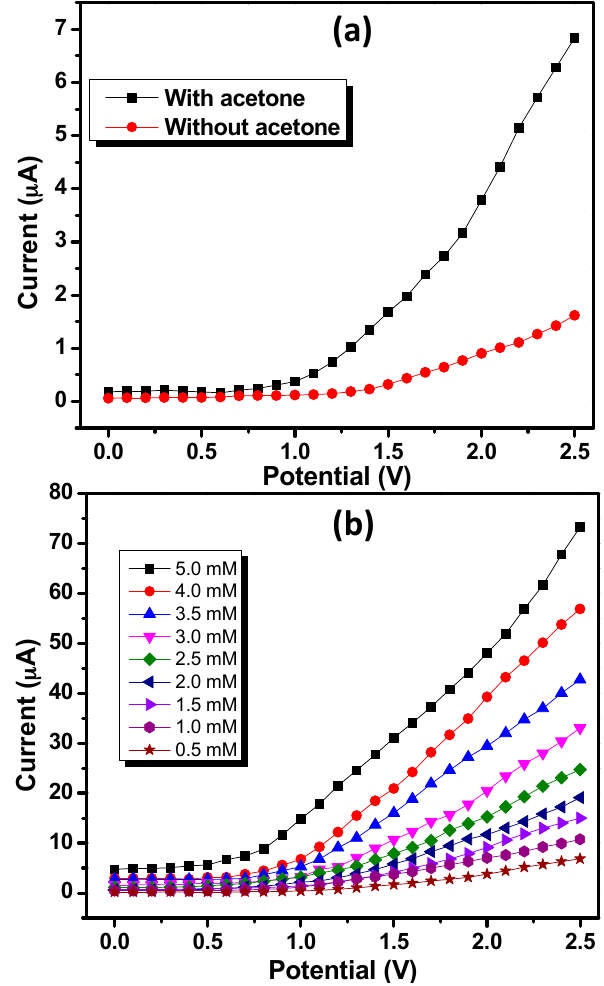
Figure 5. ( a ) I – V responses measured for 0.5 mM acetone in 0.1 M PBS solution and blank PBS solution using ZnO nanoballs modified AgE; and ( b ) I – V response variations for 0.5 mM–5.0 mM concentrations of acetone in 0.1 M PBS